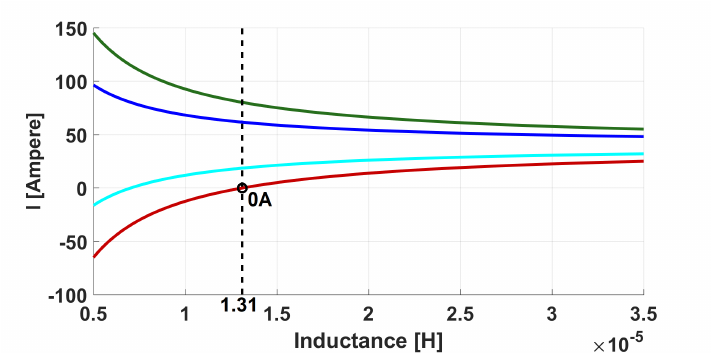
Figure 7. Inductor current during boost mode. I peak with V grid = 57 V (green curve), I peak with V grid = 50 V (blue curve), I min with V grid = 50 V (cyan curve) and I min with V grid = 57 V (red curve).